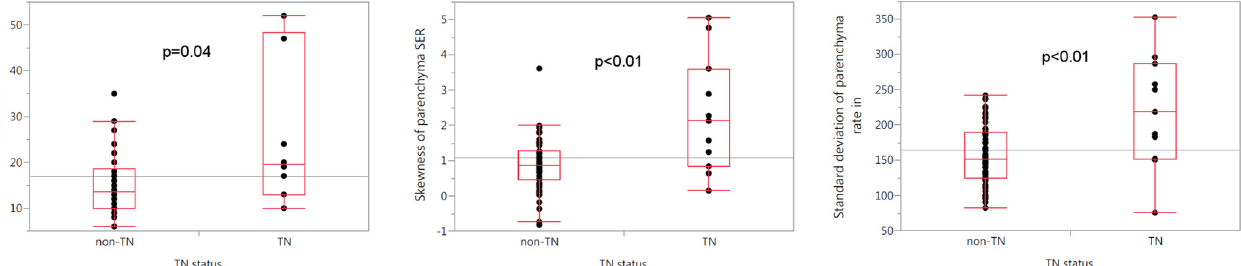
Fig 3. Box plots illustrating differences in distributions (quartiles as red boxes, grand mean indicated as spanning line) of the three most predictive quantitative features found in differentiation tasks: the lesion ’ s ‘ mass size ’ feature (a), parenchyma ’ s ‘ skewness of Signal Enhancement Ratio ’ feature (b), and parenchyma ’ s ‘ standard deviation of rate in ’ feature (c) compared between the triple-negative (TN) and non- TN groups. p-values were calculated by Wilcoxon Mann-Whitney tests.